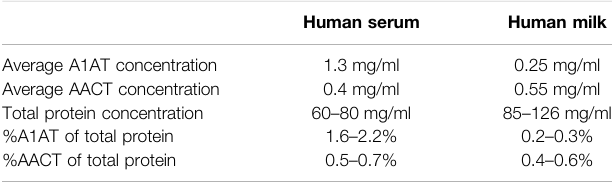
Human serum Human milk